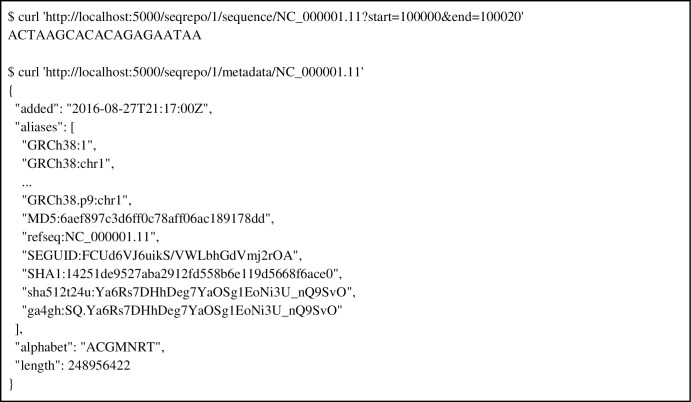
Examples of the SeqRepo REST API.See the SeqRepo repository for installation instructions and S2 Code for example details.